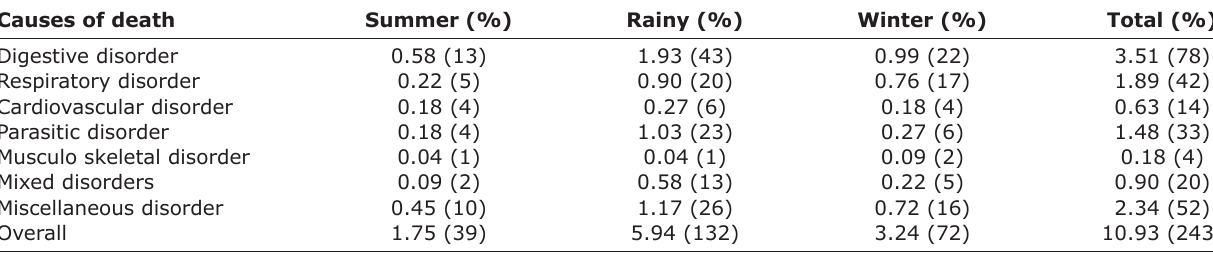
Table-4: Causes and season wise mortality rate in Rohilkhand local goat. Causes of